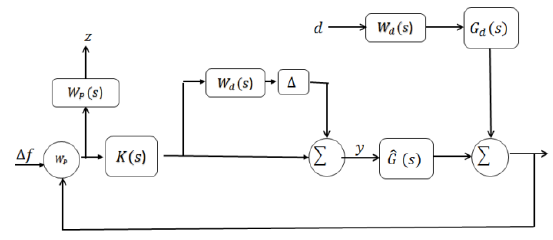
Figure 6. System setup for robust performance.